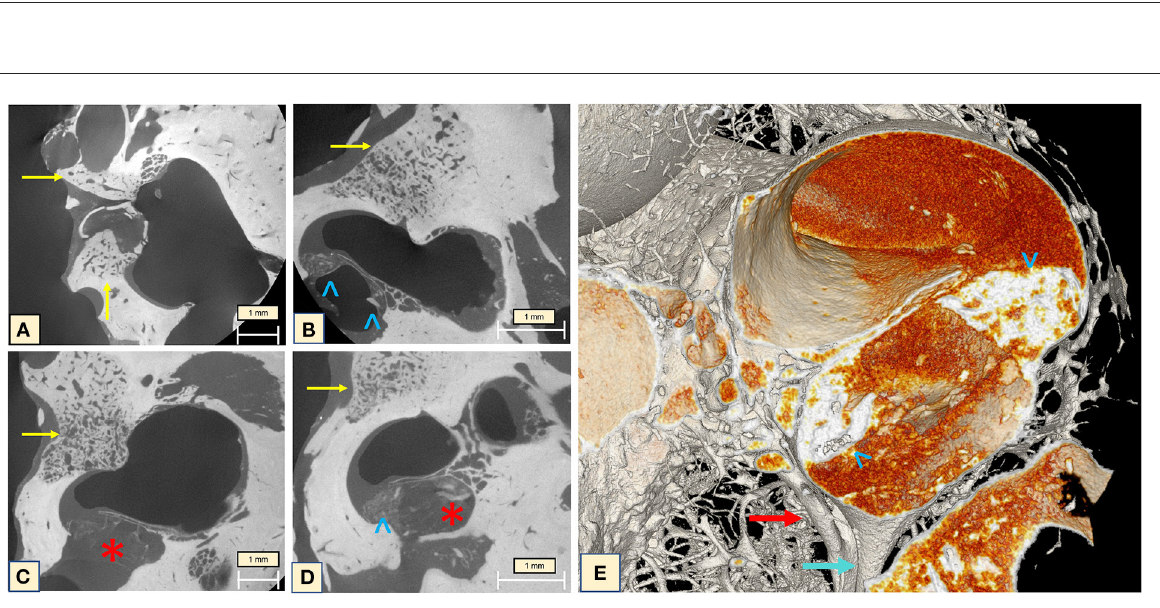
FIGURE4 (A) The oval window with the fractured stapes and otospongiotic bone (yellow arrows) with multiple dilated vessels; (B) the oval window is surrounded by spongiotic bone (yellow arrow) and lithic formation of the CP and under the OSL (blue arrowheads); (C,D) otospongiotic bone (yellow arrows) surrounding the round window and fibrotic tissue taking over the scala tympani region (red star) and lithic formations (blue arrowheads). (E) 3D mesh reconstruction of the region immediately posterior to the round window (RW), reveals intense dense bone formation on the CP (blue arrowheads) and the cochlear aqueduct (CA) (blue arrow) and the inferior cochlear vein (ICV) next to it (red arrow). The orange image taking over the compartment corresponds to the fibrotic tissue seen on the microCT. Note how the fibrotic tissue (“red cloud”) obliterates both CA and